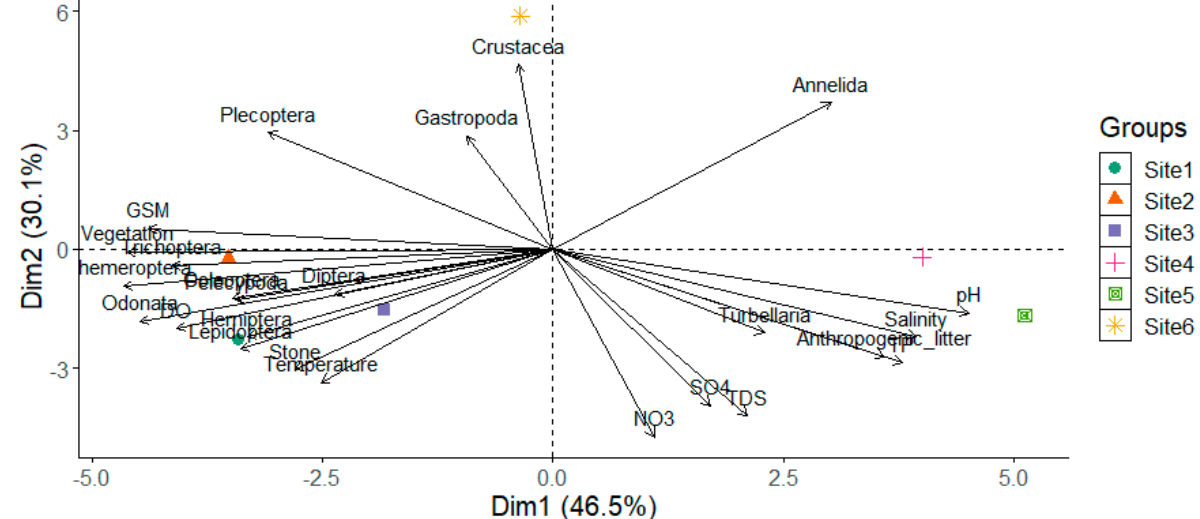
Figure 2. Principal Component Analysis ordination plot showing the association between environmental variables, habitat, taxa, and sampling sites.